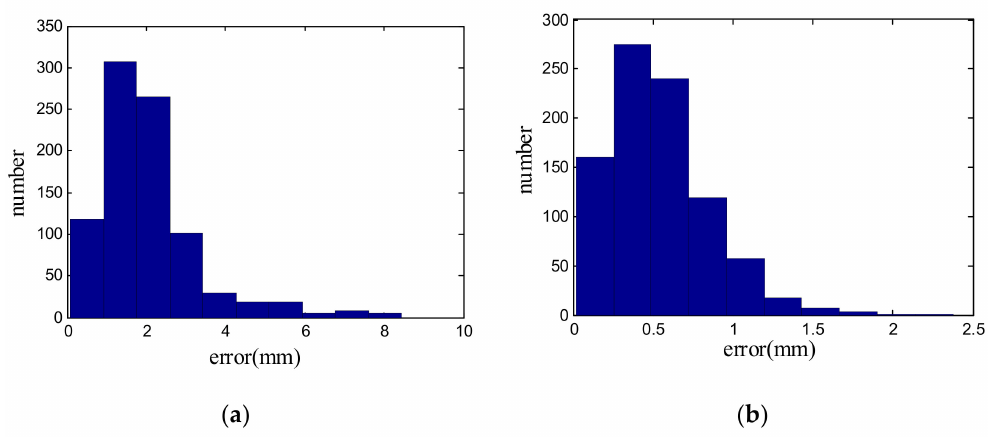
Figure 16. Errors distribution, ( a ) Errors distribution before correction ( b ) Errors distribution after